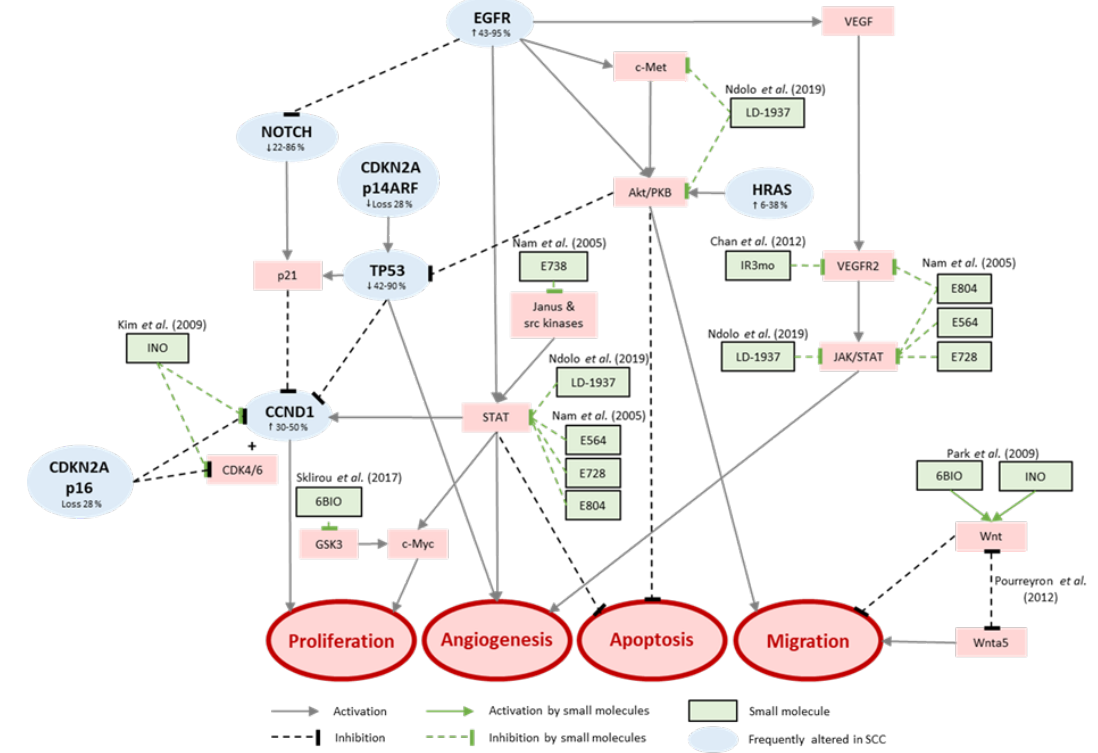
Figure 2. Indirubins interacting with signaling pathways frequently altered in squamous cell carcinoma of the skin.